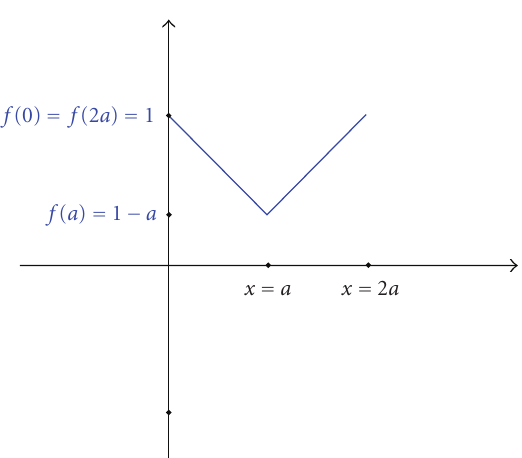
Figure 3.5. A maximizing form for the 3 circles example. We plot f for the form given by f ( x ) dy . We are forced to use α = 1 and the Lipschitz form plotted